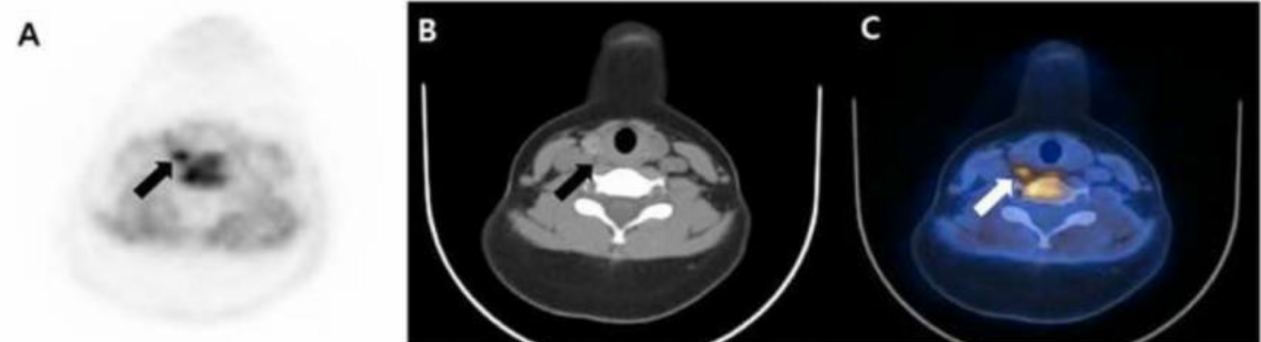
Figure 3. 11 C-Methionine positron emission tomography/CT ( 11 C-MET PET/CT) ( A ) PET image; ( B ) CT image; ( C ) fusion PET/CT image) was performed for primary site localization of primary hyperparathyroidism (pHPT) and showed a small lesion in the posterior aspect of the right thyroid gland (arrow). Right parathyroidectomy was performed and pathologically indicated a 0.8-cm-sized parathyroid adenoma. Since the operation, both parathyroid hormone and serum calcium levels have normalized (31.4 pg/mL and 9.8 mg/dL,